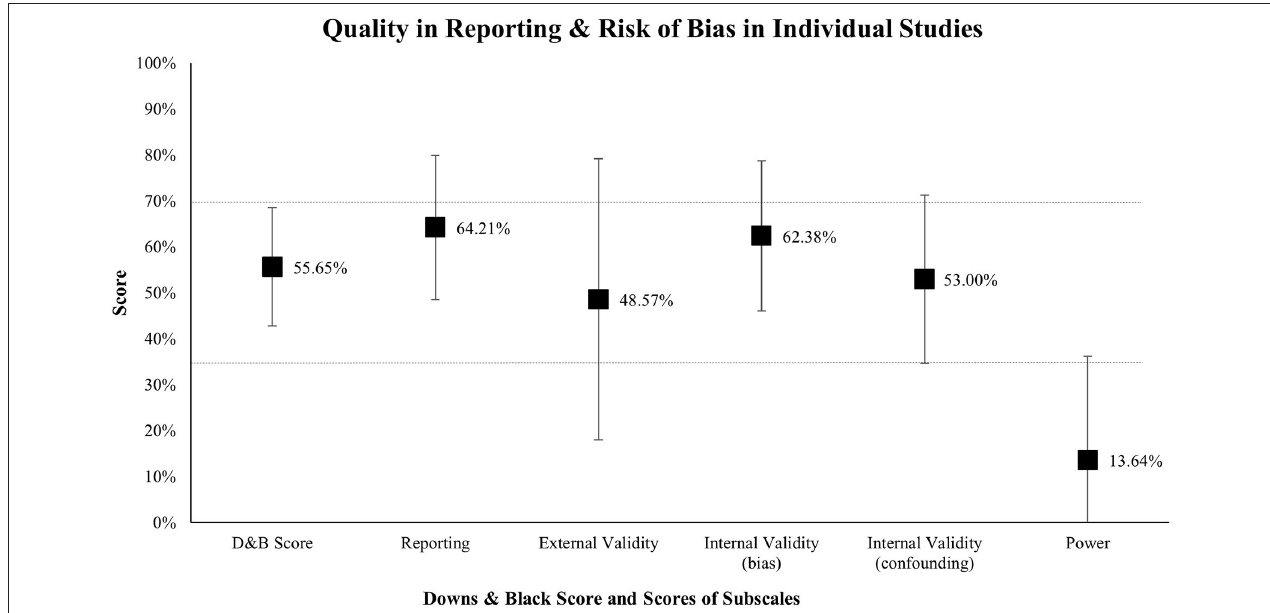
FIGURE 2 | Quality in reporting and risk of bias in individual studies. D&B Score, Downs and Black score (all items). Notes: Results are presented as means with error bars that represent the standard deviation. The dashed lines show thresholds for low ( ≤ 35%) and high ( ≥ 70%) scores. It must be considered that the subscales external validity and power were calculated from only three and two items,